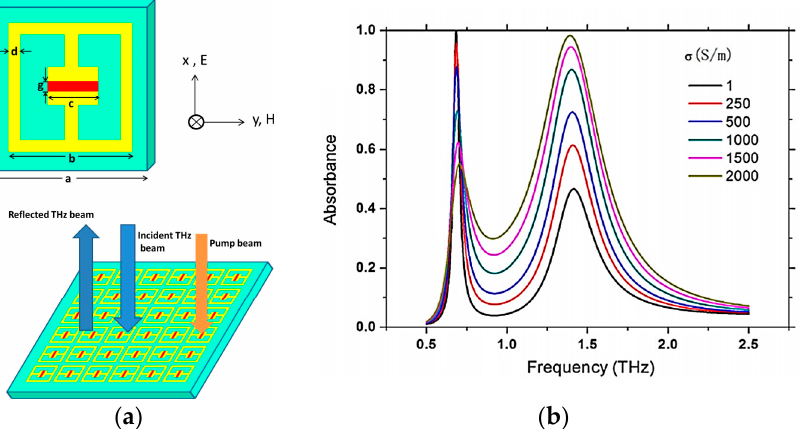
Figure 21. Tunable metamaterial absorber based on photosensitive silicon ( a ) structure and ( b ) absorption curve with silicon conductivity [58].